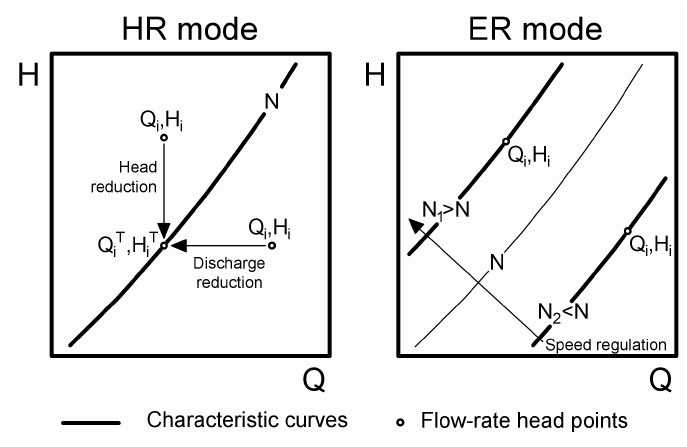
Figure 2. PAT operating conditions in hydraulic ( left ) or electrical ( right ) regulation